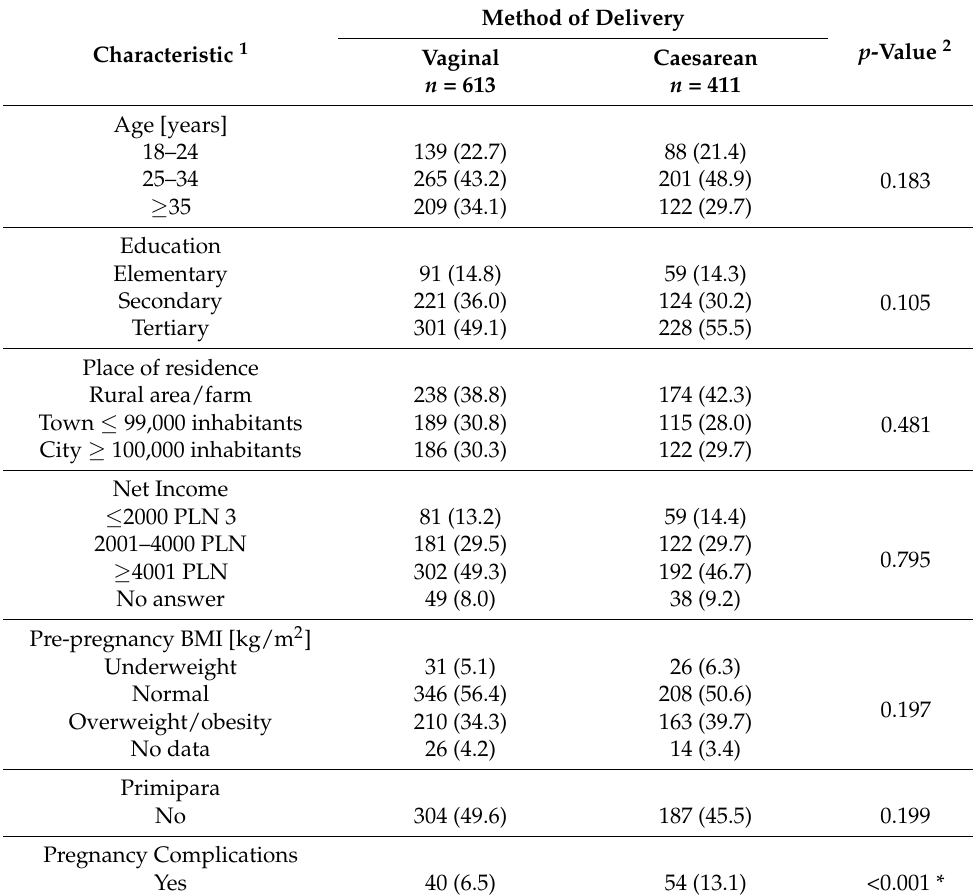
Table 1. Demographic characteristics and gestational information in the subgroups depending on the method of delivery ( n =